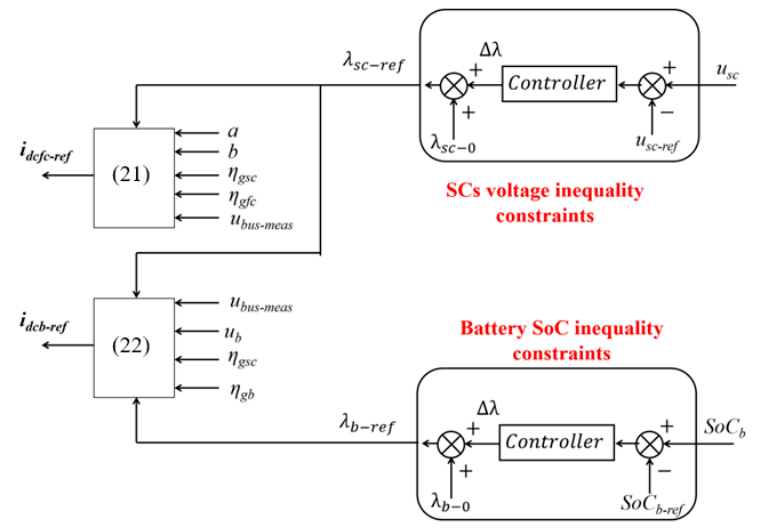
Figure 8. λ -control strategy scheme.